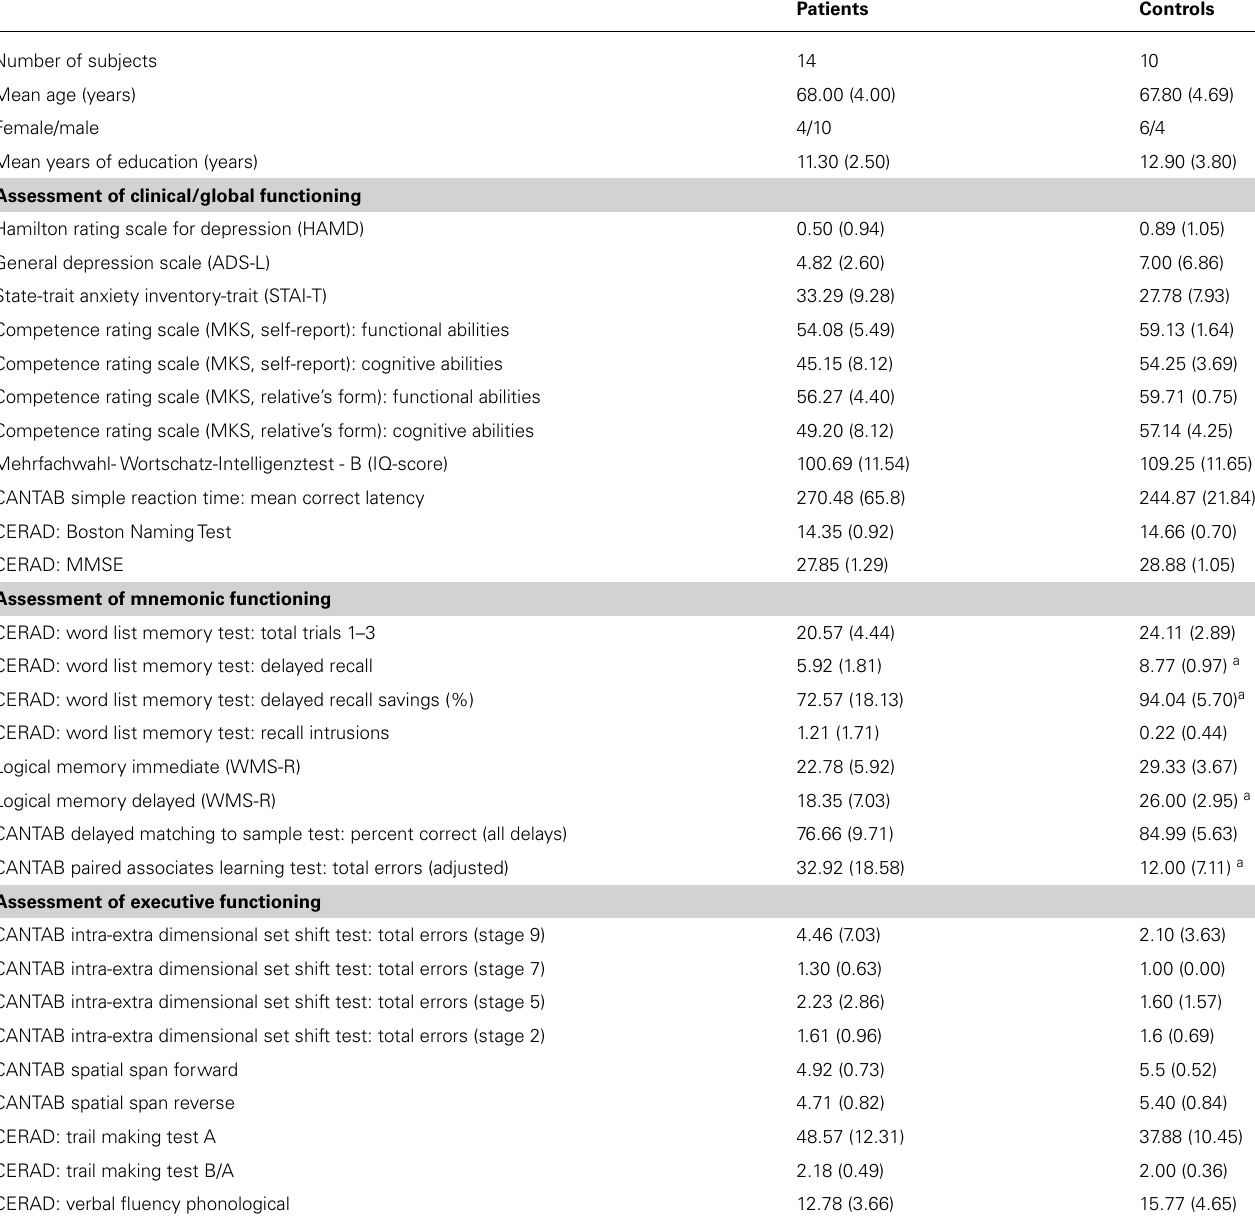
Table 1 | Measures of clinical and global functioning, episodic memory, and executive functioning and statistical comparison of the patient and control group (N or mean value, SD in parentheses).